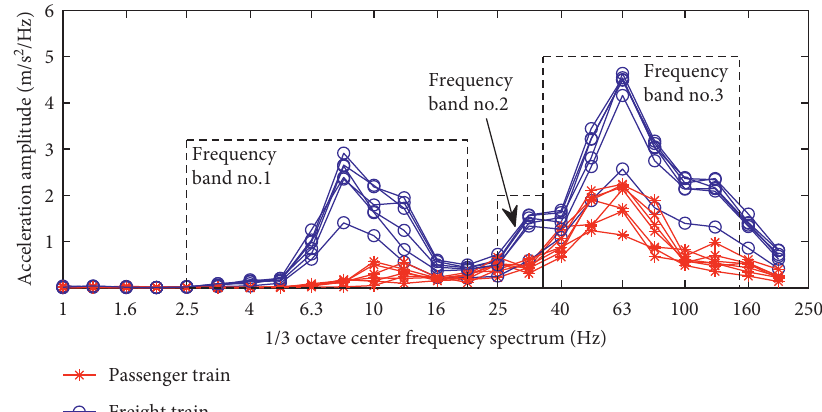
Figure 7: One-third-octave center-frequency spectrum induced by different types of trains ( P